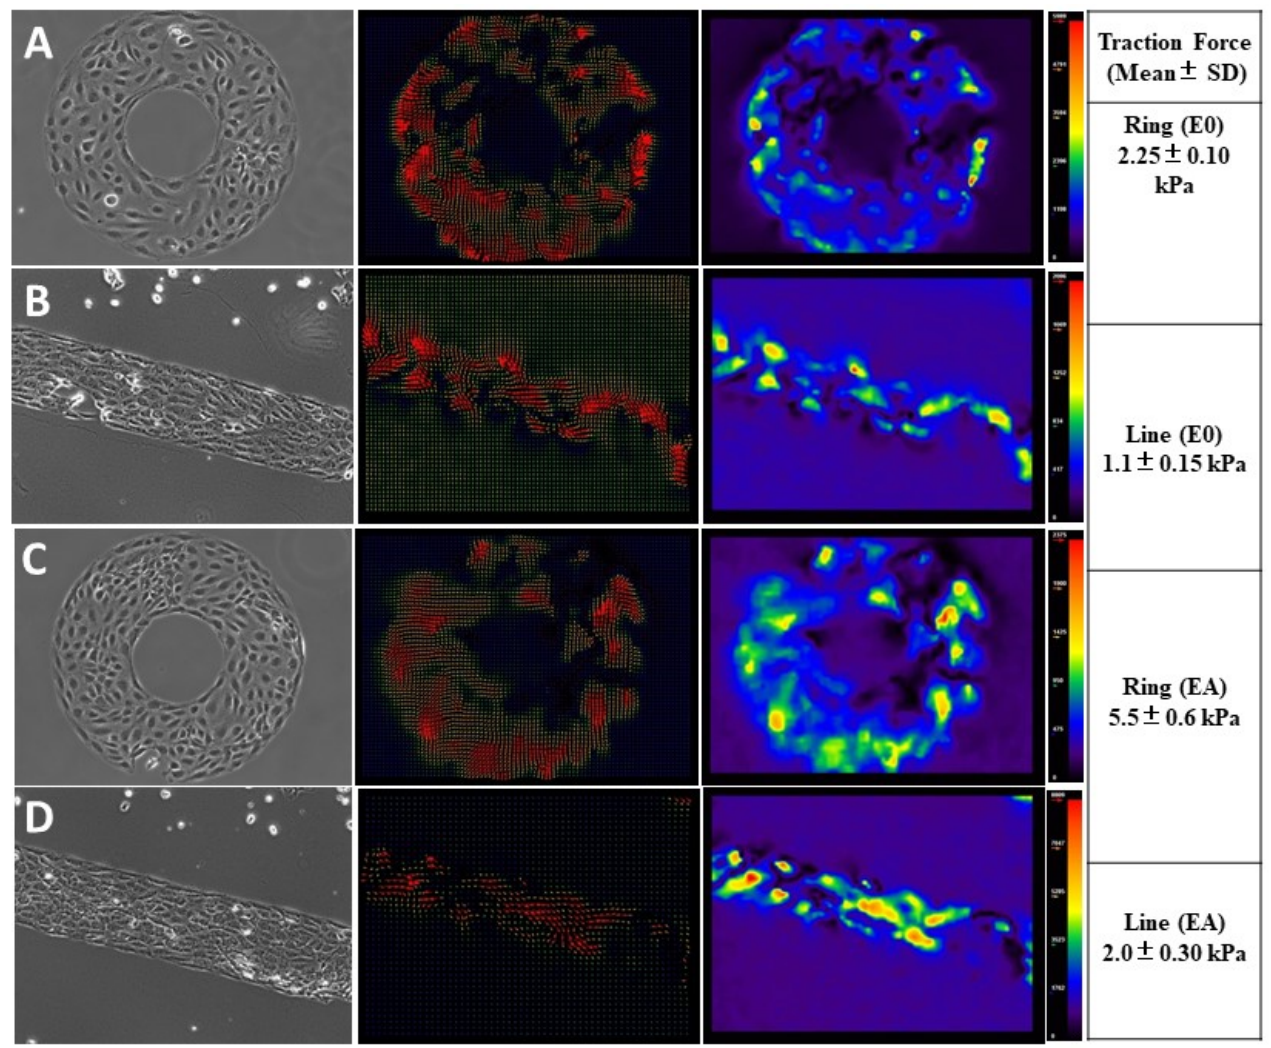
Figure 4. Phase contrast images of hUVECs (left panel) on PAG constrained by microcontact printing (10× magnification). The magnitude and vector map (middle and right panel) displaying the force distribution and direction of the bead displacement on the underlying ring/line micropatterns in the transwells in the absence ( A , B ) and presence ( C , D ) of astrocyte co-culture (scale bar: 50 µm).